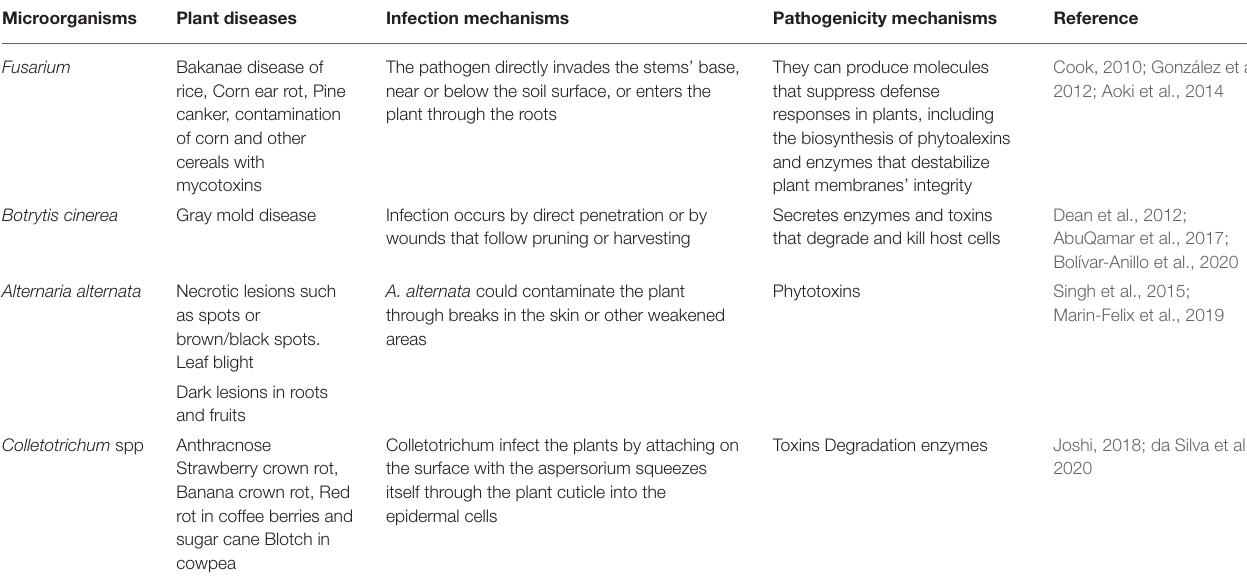
TABLE 2 | Major phytopathogenic Fungi with a critical impact in agriculture.